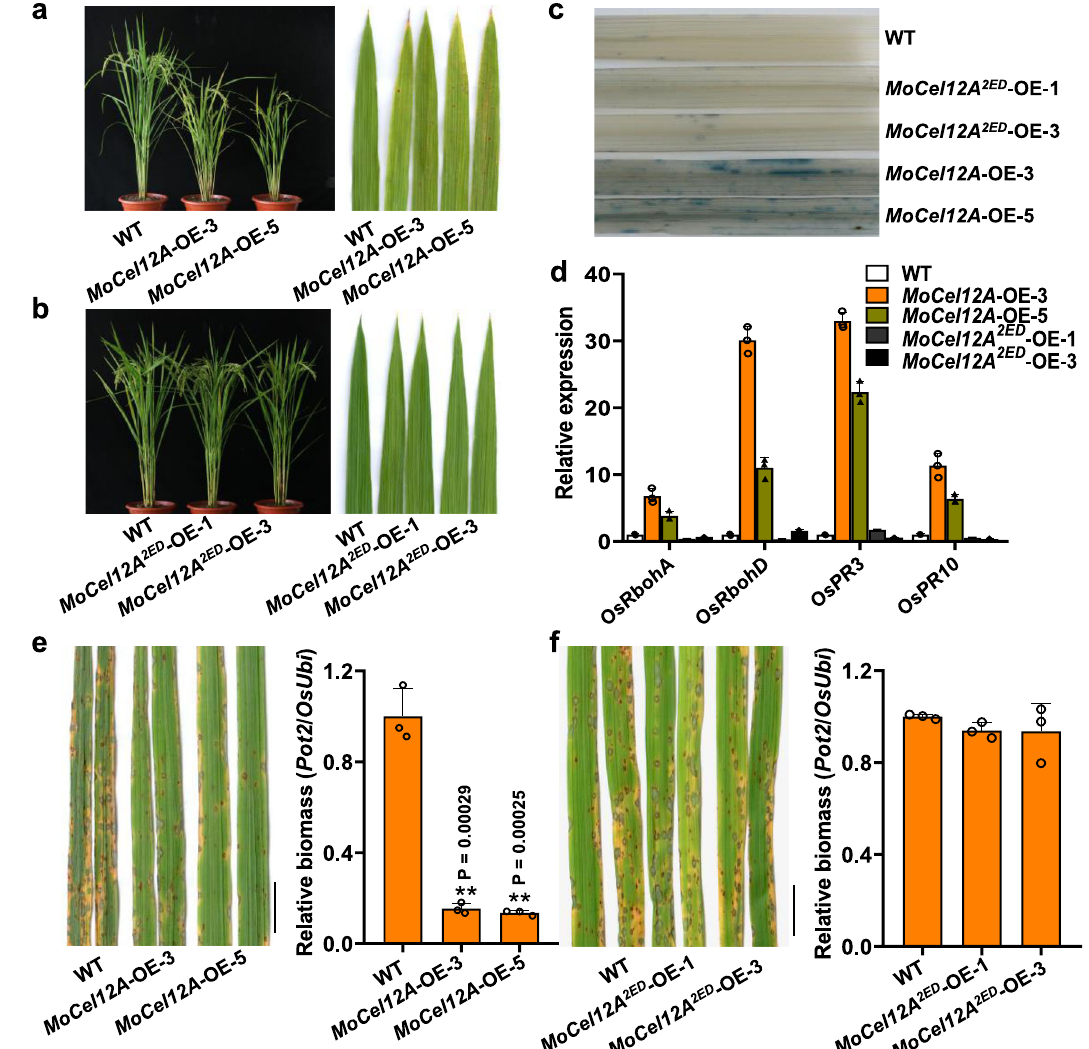
Fig. 2 Ecotopic expression of MoCel12A increased the blast disease resistance in rice. a Phenotype of the architecture (left) and the leaf lesions (right) of MoCel12A -expressing plants. Wild-type (WT) and MoCel12A ecotopic-expression plants ( MoCel12A -OE) were grown in paddy soil and photographed at the heading stage. WT is empty vector control. OE-3 and OE-5 are two independent transgenic lines. b Phenotype of the architecture (Left) and the leaf lesions (Right) of MoCel12A 2ED expressing plants. WT and MoCel12A 2ED ecotopic-expression plants were grown as in ( a ). OE-1 and OE-3 are two independent transgenic lines. c Trypan-blue staining of rice plants ecotopically expressing MoCel12A and MoCel12A 2ED . d Rboh and PR gene expression in WT, MoCel12A , and MoCel12A 2ED transgenic plants. The leaves of 4-week-old plants were sampled, and RT-qPCR was used to evaluate the gene expression. Os Actin served as the internal reference gene. Values are means ± SD ( n = 3 biological replicates). e MoCel12A -OE expression plants exhibit enhanced disease resistance to M. oryzae . Left: disease symptoms of WT and MoCel12A -OE leaves infected with Guy11. Conidial suspensions (1 × 10 5 conidia per ml in 0.02% Tween- 20) were sprayed onto the leaf surfaces of 2-week-old rice seedlings. The images were taken at 5 dpi. Bar = 1 cm. Right: the relative fungal biomass determined by qPCR. Values are means ± SD ( n = 3 biological replicates). ** indicates signi fi cant differences from WT at P < 0.01 (two-sided Student ’ s t test). f Expression of inactive MoCel12A in rice did not affect the blast disease resistance. Left: disease symptoms of WT and MoCel12A 2ED -OE leaves infected with Guy11. Right: relative fungal biomass. Others are as in ( e